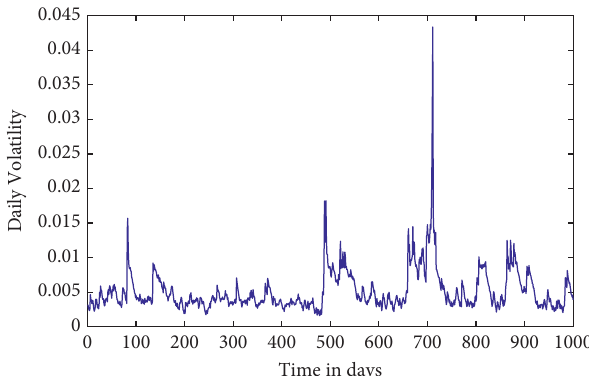
Figure 9: The validation of volatility of daily S&P 500 data for T � 1000.